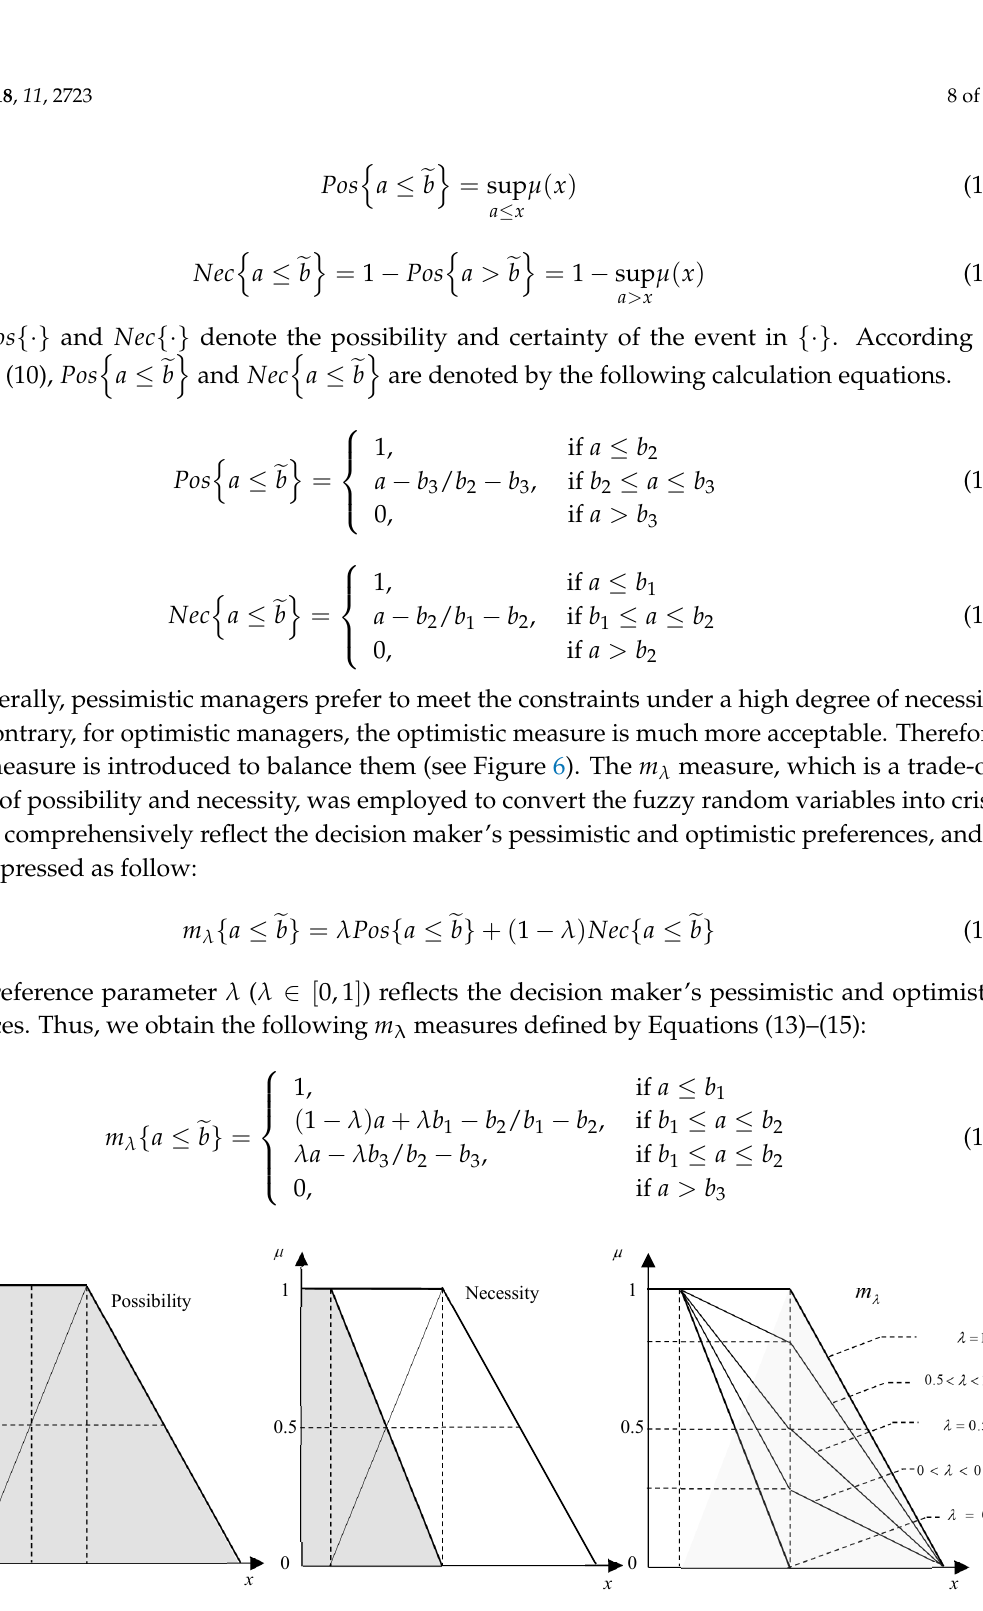
Figure 6. Three measures of a fuzzy event including fuzzy set.